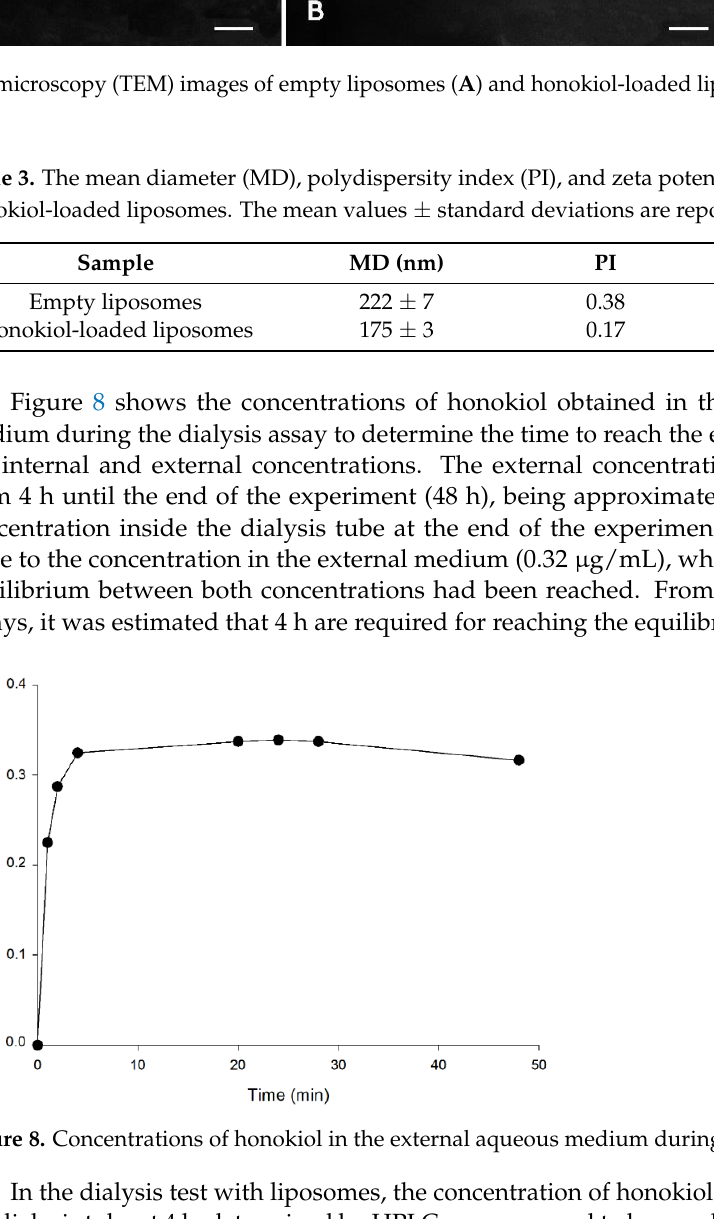
Figure 7. Transmission electron microscopy (TEM) images of empty liposomes ( A ) and honokiol- loaded liposomes ( B ). Bars correspond to 50 nm.